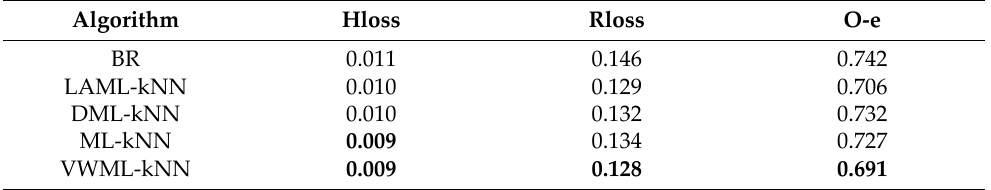
Table 3. Experimental results from different multilabel classification methods on the Corel5k dataset.